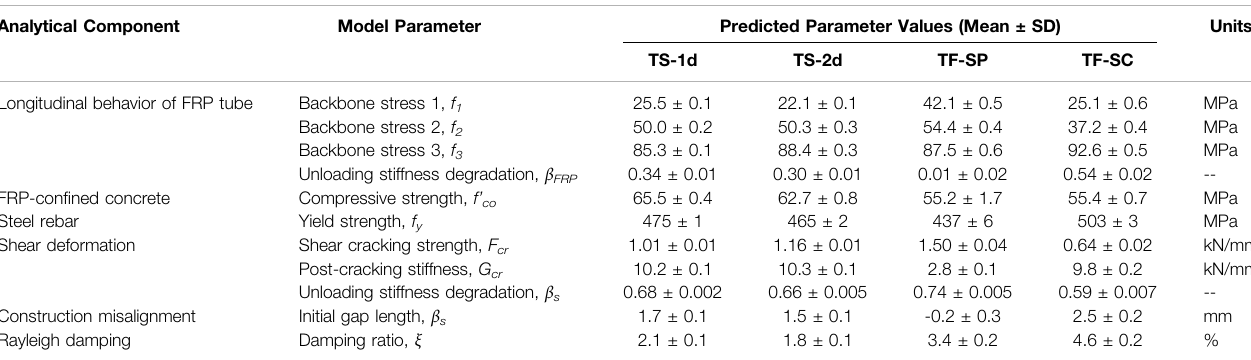
TABLE 4 | Predicted values of key model parameters for experimental data with added noise. Analytical